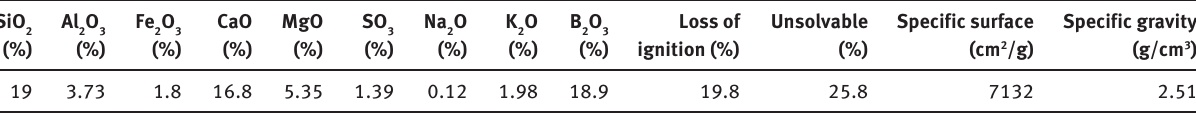
Table 4 Physical and chemical properties of colemanite waste. SiO 2 (%)